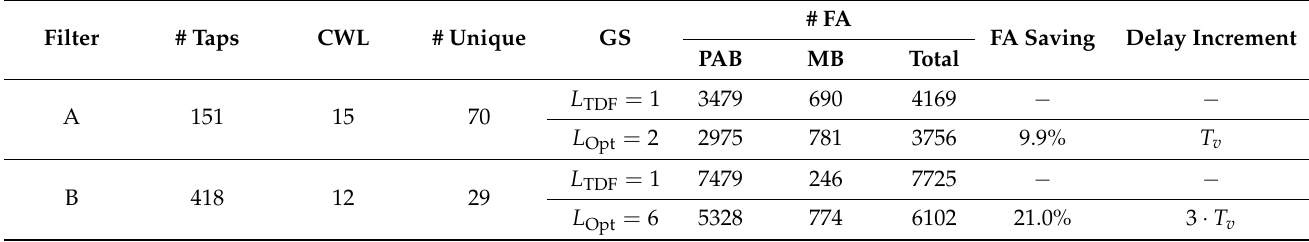
Table 1. Hardware complexity of two benchmark filters